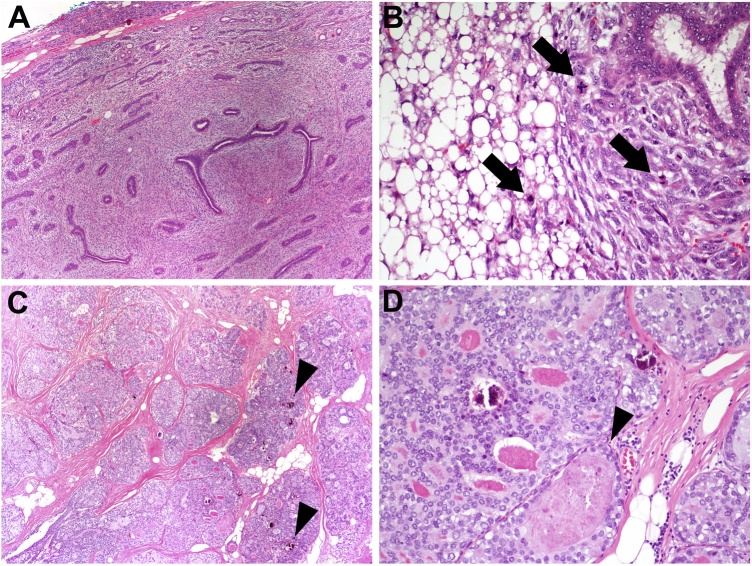
Malignant phyllodes tumor with ductal carcinoma in situ (DCIS) in surrounding tissue. (A) Low-power magnification image shows a well-circumscribed phyllodes tumor with moderately cellular stroma. (B) Some areas of the phyllodes tumor demonstrated increased periductal stromal cellularity (right) with numerous mitoses (arrows), including atypical forms, and malignant liposarcomatous transformation (left). The stromal cells demonstrate marked cytologic atypia. (C) The subsequent re-excision specimen shows expanded ducts involved by DCIS with solid and cribriform architectural growth and calcifications (arrowheads). (D) Higher magnification of DCIS shows a monotonous population of ductal epithelium with intermediate grade nuclei and focal necrosis (arrowhead). The final re-excision demonstrated similar DCIS with calcifications (not shown).